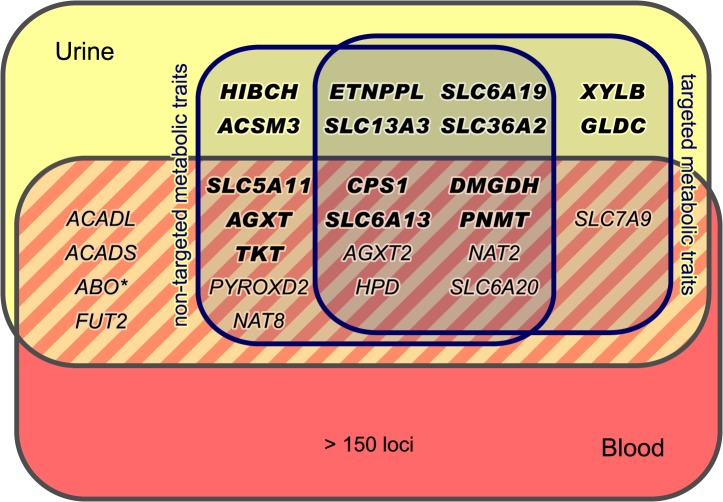
Loci with associated urinary metabolic traits and their overlap with previous mGWAS in blood and urine.We identified and replicated genome-wide significant associations between metabolic traits and genetic variants in 22 genetic loci (named after the most likely causative gene). Three loci could only be identified using targeted metabolic traits, while 7 loci were exclusively discovered with non-targeted traits. 12 loci were identified using both targeted and non-targeted approaches. Loci with hitherto unknown associations with urinary metabolic traits are highlighted (totaling 15). We identified and replicated significant associations in 7 of the 11 loci that were reported in previous mGWAS in urine [5, 10–12]. We also discovered significant associations of the ABO locus (marked with an asterisk) with non-targeted traits, but this locus could not be replicated in KORA F4. When compared to previous mGWAS in blood, we find 14 loci that display associations with metabolic traits in both urine and blood [1, 4, 6–8, 14–24].